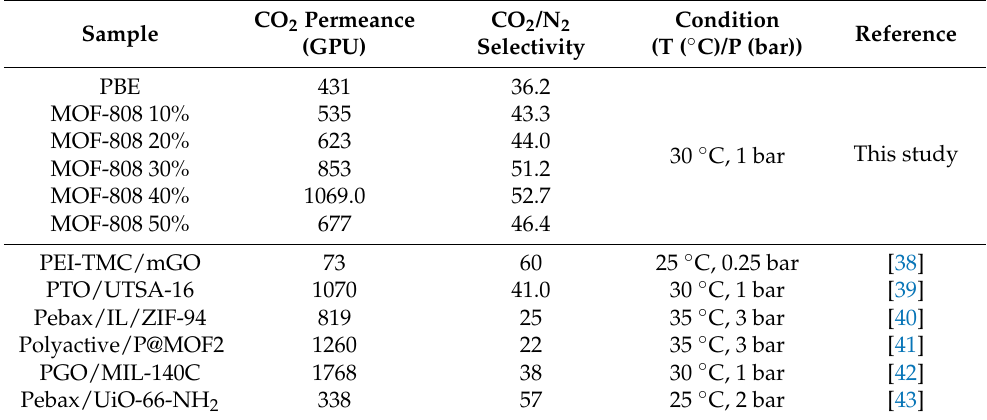
Table 1. CO 2 separation performance of PBE/MOF-808 membranes and previously reported TFC-MMMs.